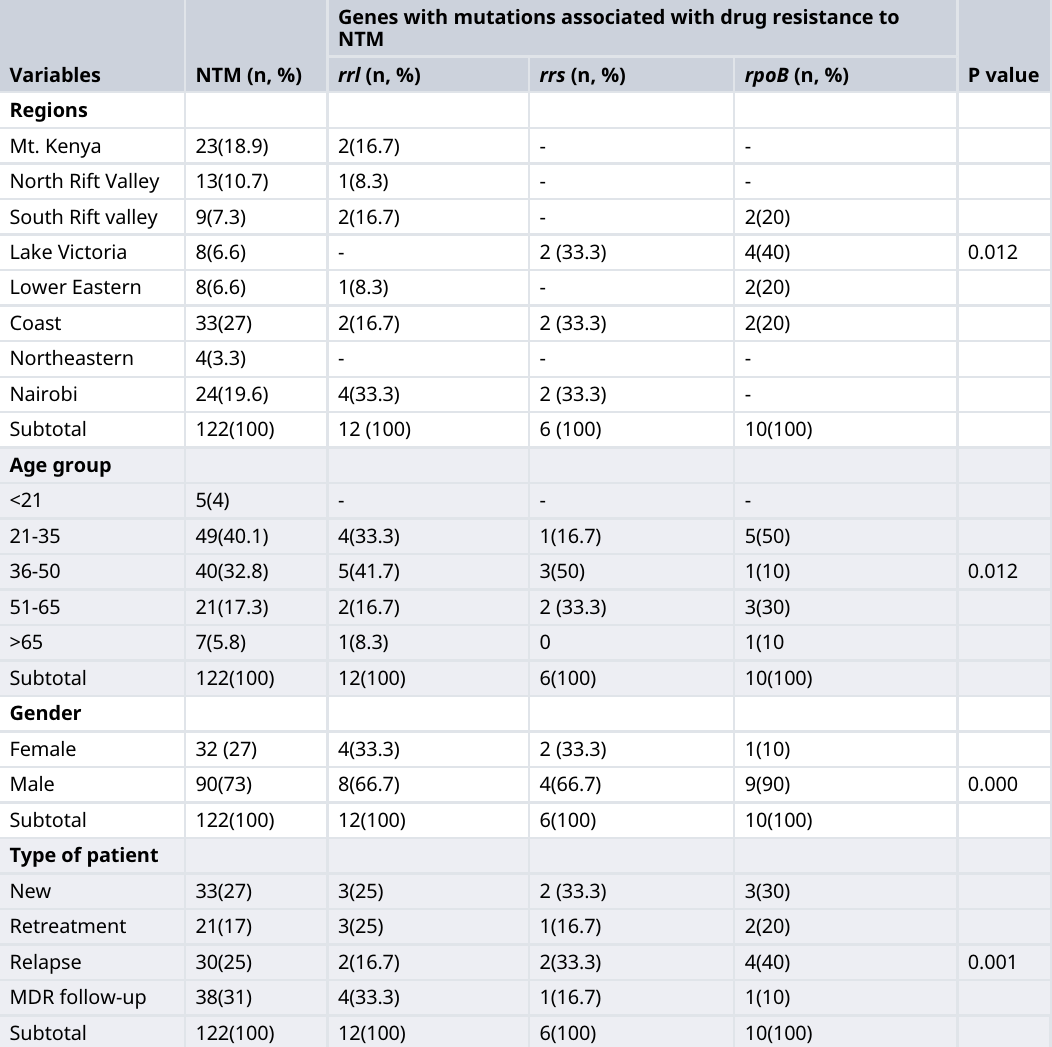
Table 2. Sociodemographic characteristics of patients with drug-resistant NTM. Genes with mutations associated with drug resistance to Variables NTM (n, %)